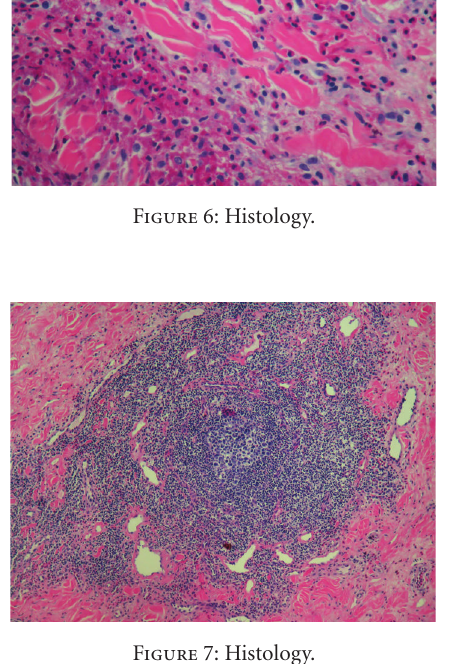
Figure 7: Histology.